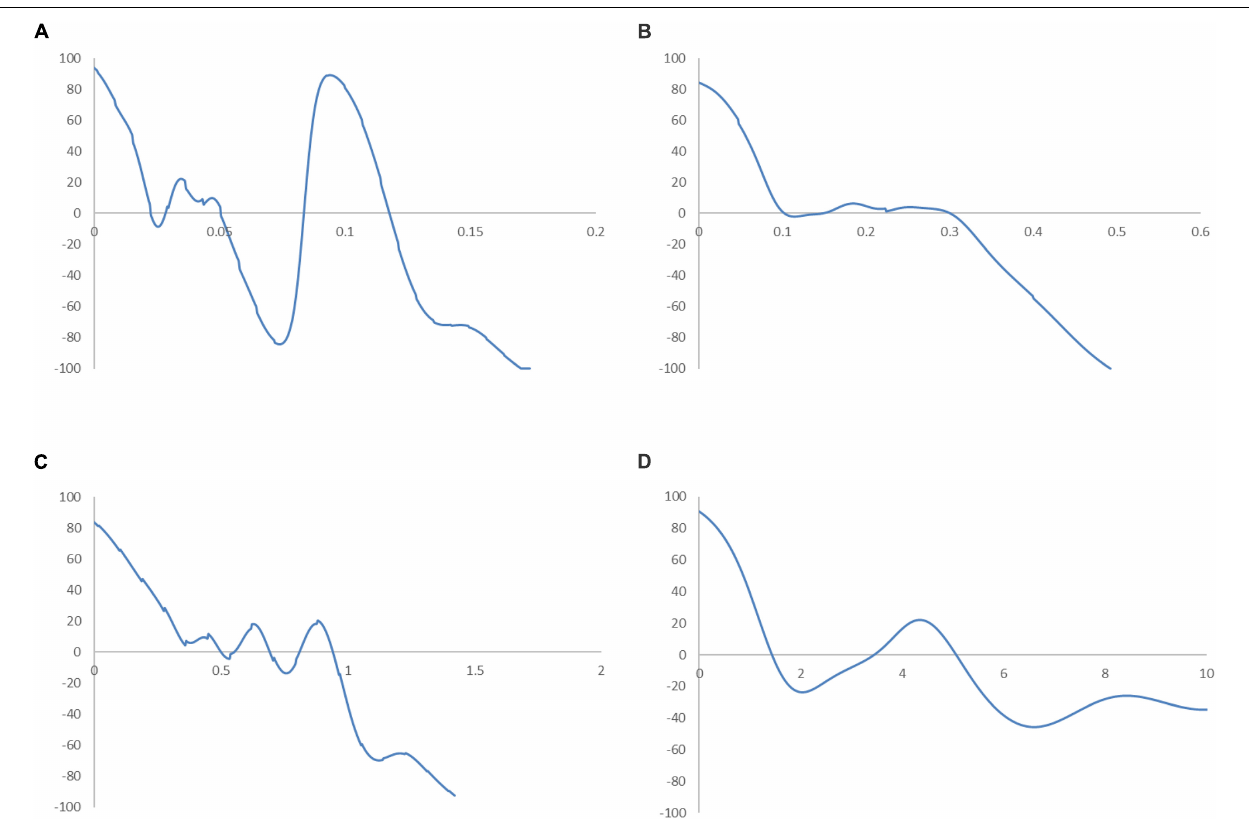
FIGURE 12 | Mobility probability plot (MPP) for the RSVAPC of countries for different income groups of countries. Source: Authors’ calculation. N.B. The vertical axis indicates net upward mobility (%) and the horizontal axis indicates RSVAPC values. (A) Low-income countries; (B) Lower-middle income countries; (C) Upper-middle income countries; (D) High-income